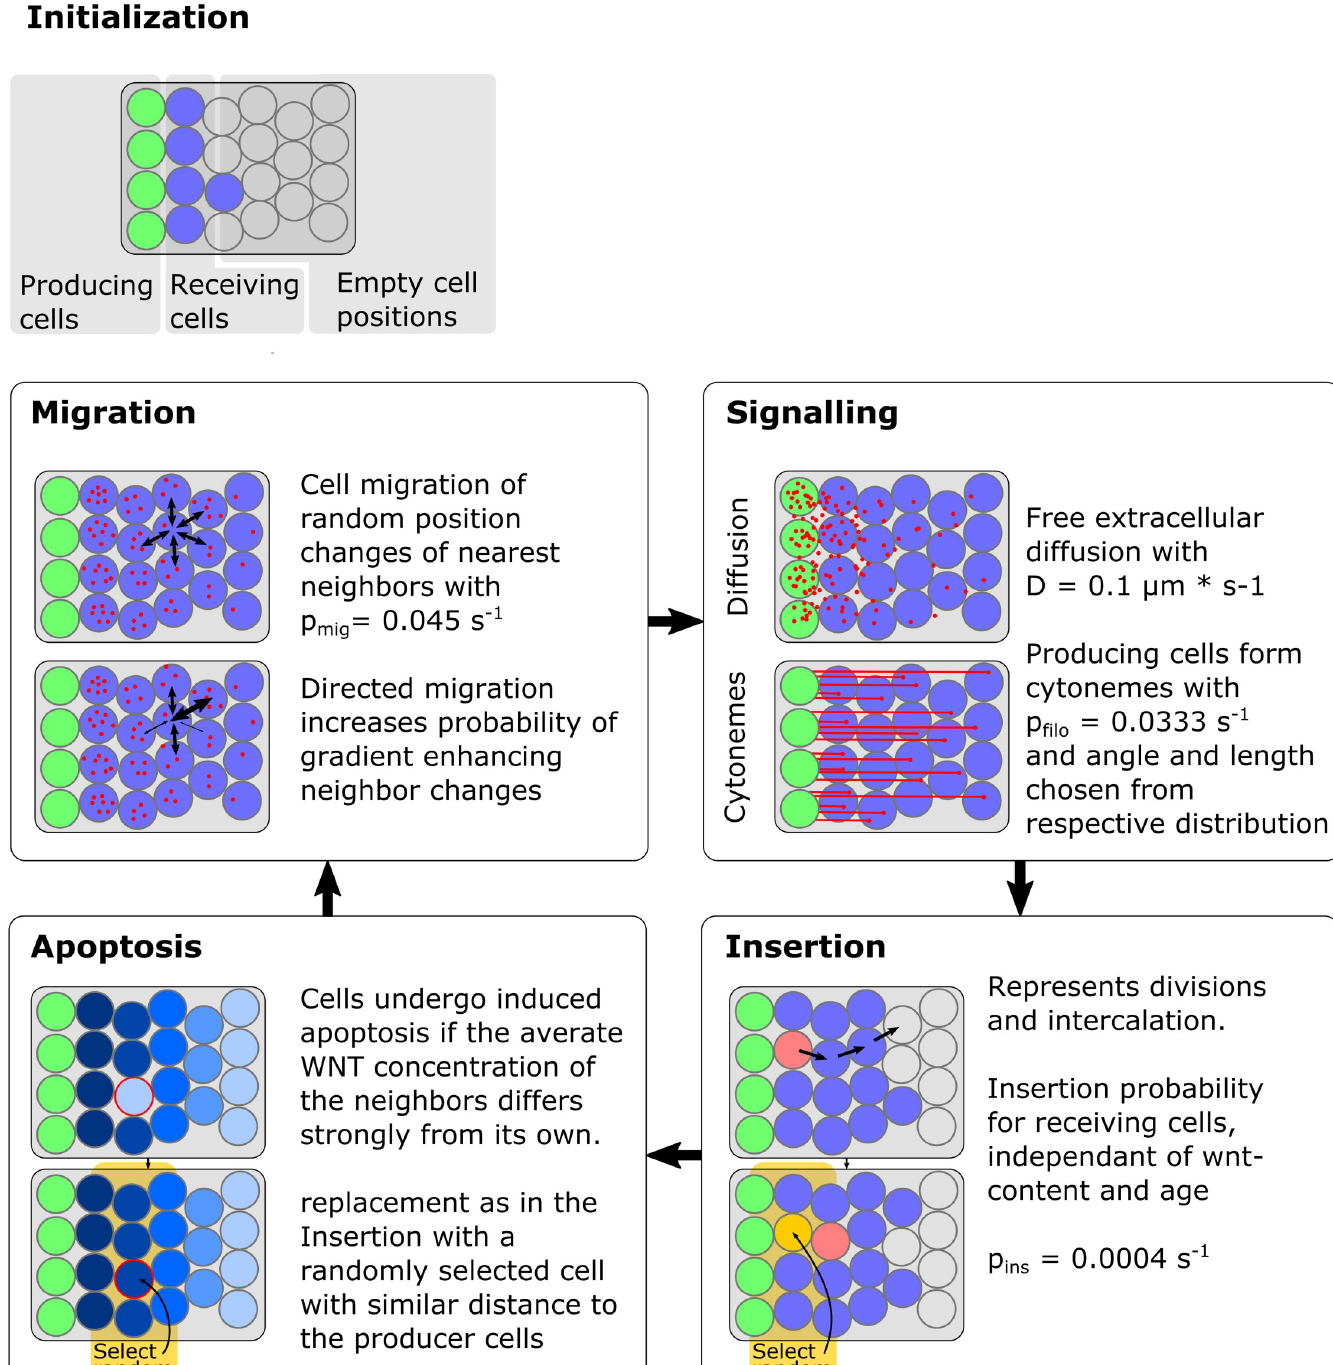
Fig 8. Overview over the simulation method and model parameters. The field in which the tissue is modeled consists of precomputed non-overlapping potential cell positions (“fixed irregular lattice sites”). To initialize a simulation one margin of the field is filled with non-dividing morphogen producing cells (here shown in green), as well as morphogen receiving cells (shown in blue) with no initial morphogen concentration. After initialization (up to) four processes are sequentially executed for one timestep. In the signaling step morphogen is deposited from the producing into the receiving cells, either by diffusive transport or by direct cell to cell contacts via cytonemes, also some morphogen decays here in the recipient cells. Insertion drives the tissue growth and consists of two causes which cause the same effect, namely cell division and intercalation from overlying and underlying cell sheets. Here, if an insertion occurs at one cell, a path to the nearest empty cell position is determined and all cells are subsequently moved along this path, the emerging empty spot is than filled by a cell with its properties chosen randomly from all cells with similar distance to